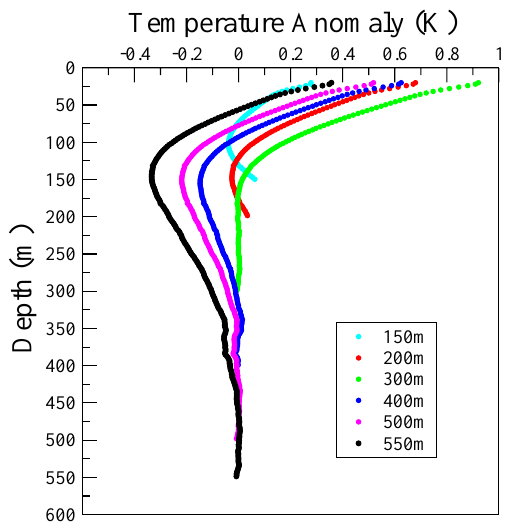
Fig. 7. Continuous temperature log for Minchin Lake (black dots). Note that only a subset of measurements have been included for clarity. The red line represents the quasi steady-state geothermal gradient estimated from a linear fit to the bottom 100m of data. Inset: black dots and red lines represent the same as above, and the blue lines denote the error calculated in the slope and the intercept of the best fit line.